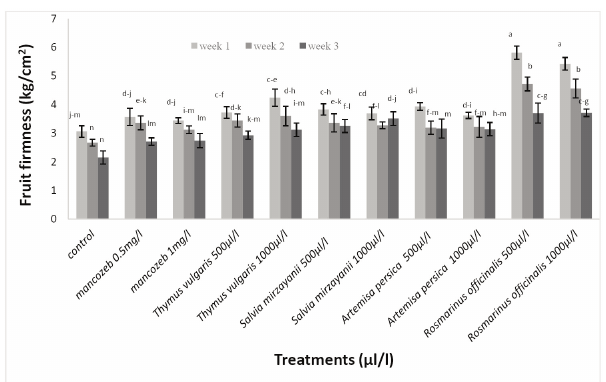
Artemisia persica and Rosmarinus officinalis EOs tested at 500 and 1000 μl/l on mangos firmness after 1, 2, and 3 weeks of incubation compared to ‘mancozed’ (0.5 and 1.0 mg/l). Bars indicate the SD of the mean. Different let- ters indicate significant differences in mean values (p